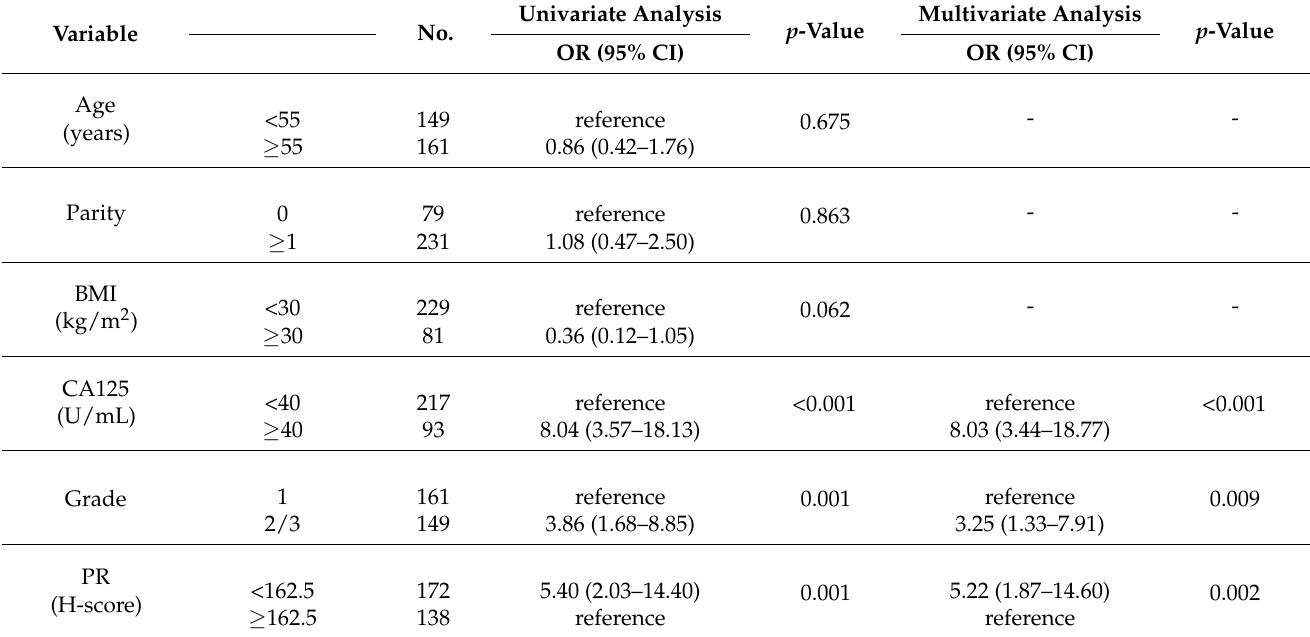
Table 2. Results of univariate and multivariate logistic regression analyses in the prediction